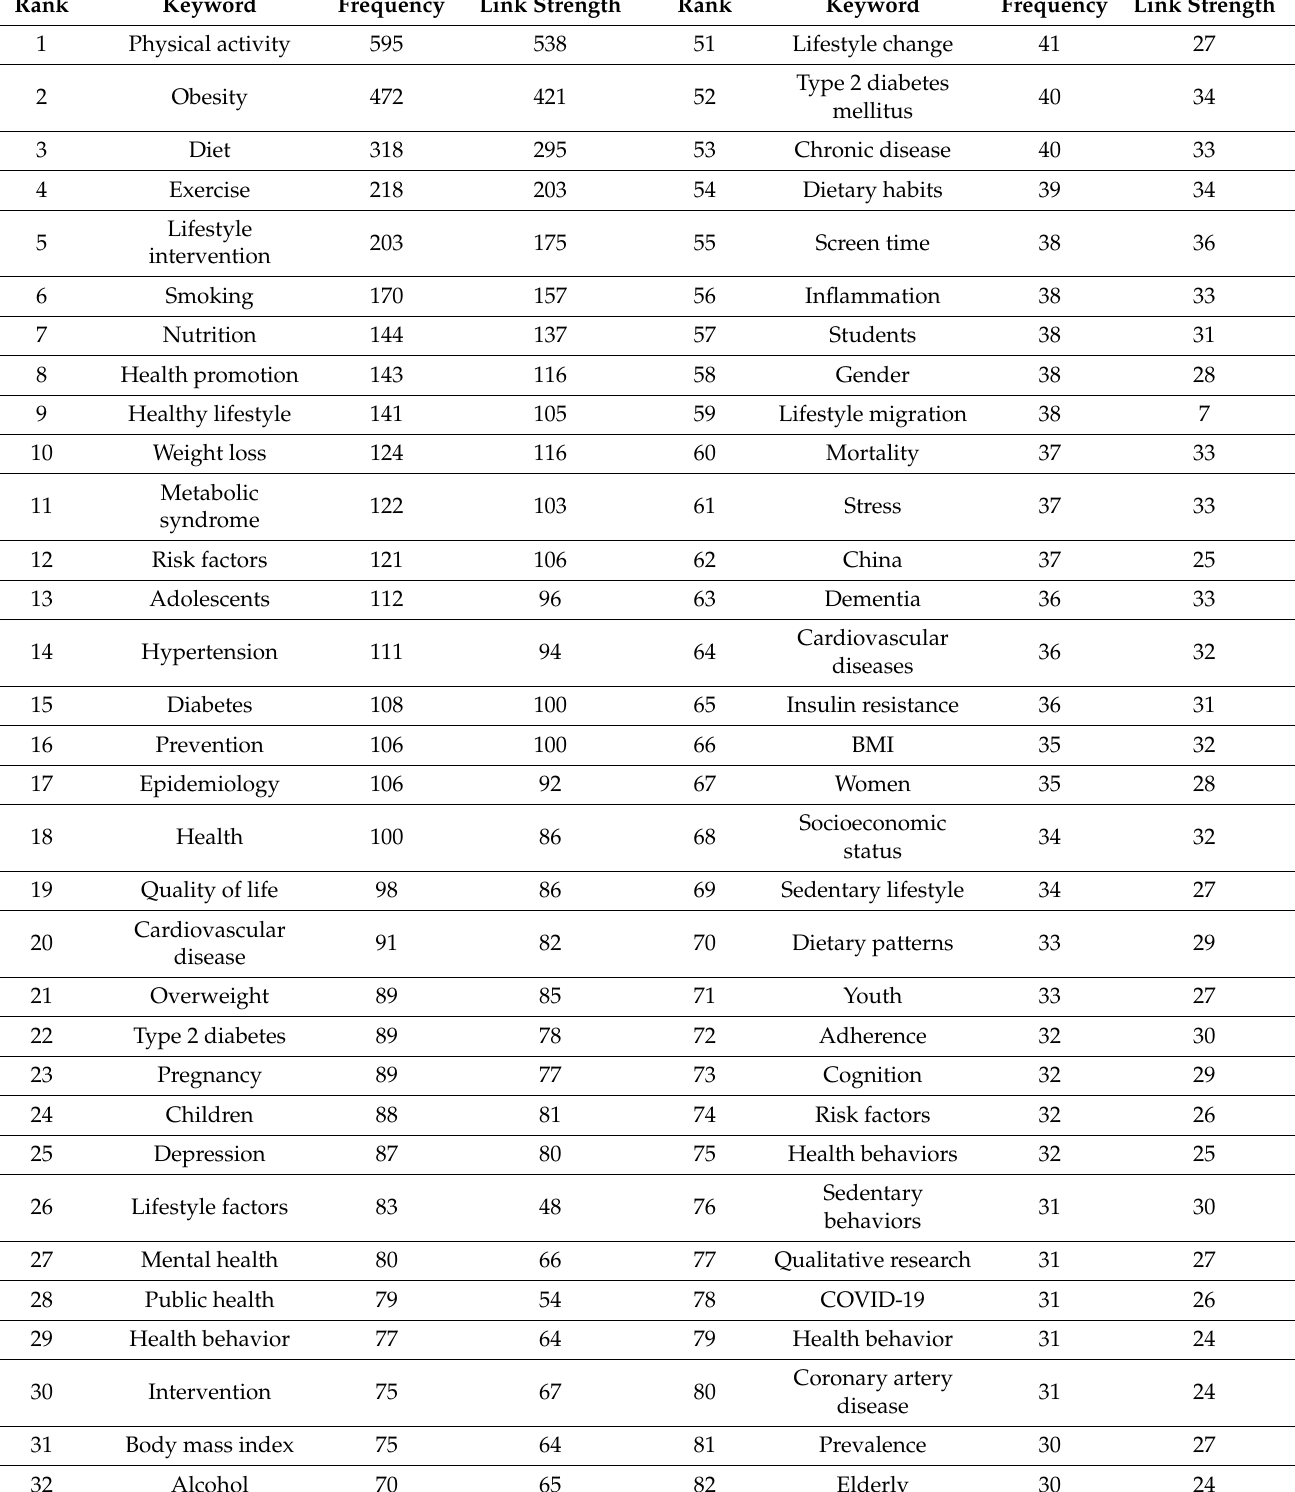
Table A1. Top 100 keywords in lifestyle research,